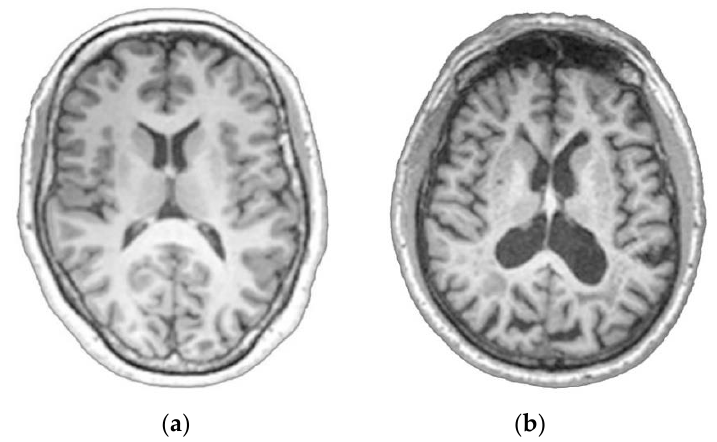
Figure 1. MRI imaging sample: ( a ) NC subject; ( b ) AD patient.